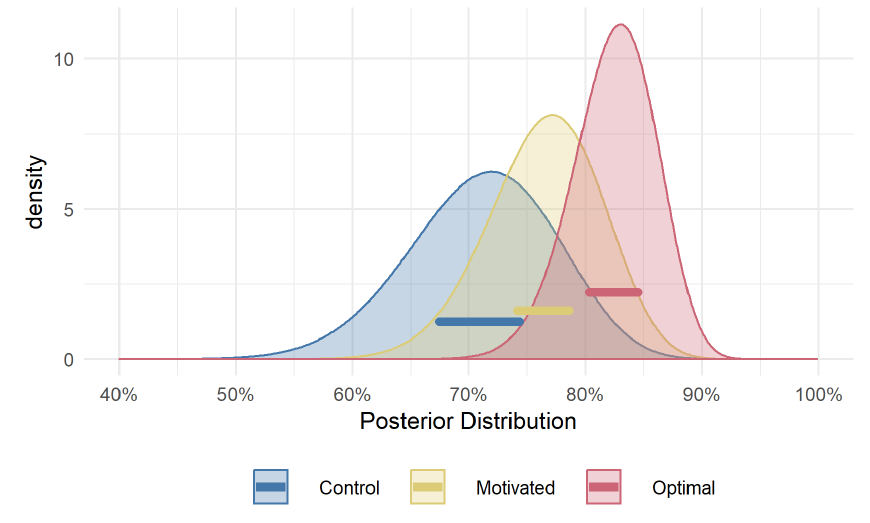
Figure 5. Posterior distributions of success rate in target detection. The lines highlight the 95% HPDI for the mean of each group’s predicted rate of